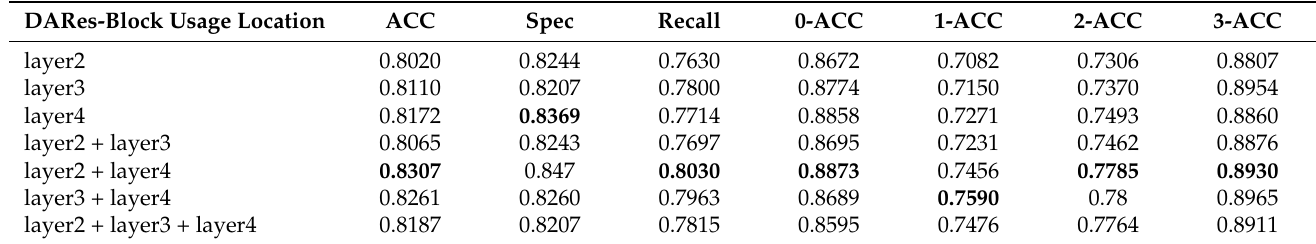
Table 1. Validation set results of comparative experiments using the location of the DARes-block module.